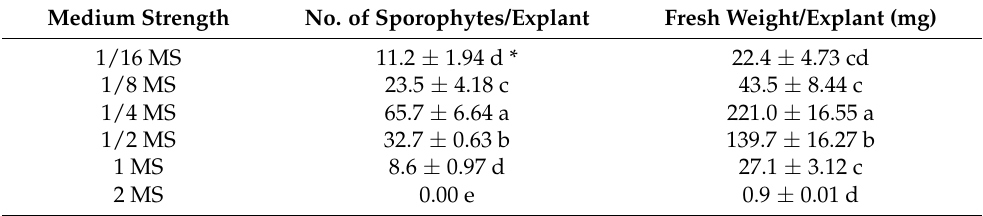
Table 1. Effect of medium strength on 10 mm shoot tip explant of Selaginella tamariscina (P.Beauv.) Spring growth and sporophyte regeneration after 12 weeks of